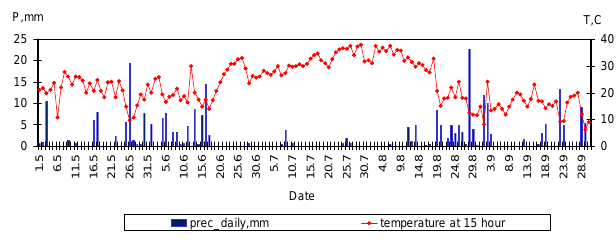
Fig. 1. Air temperature T ( ◦ C) at 15:00local time and daily pre- Fig.1. Air temperature T( ° ,C) at 15h and daily precipitation P (mm) during warm May- cipitation P (mm) during warm May–September period 2010 in September period 2010 in Moscow according to the data of Meteorological Observatory of Moscow State University. Moscow according to the data of Meteorological Observatory of Moscow State